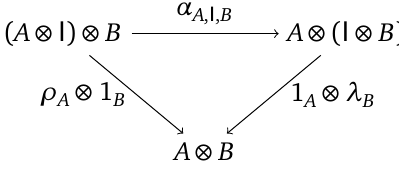
Figure 1: The triangle diagram